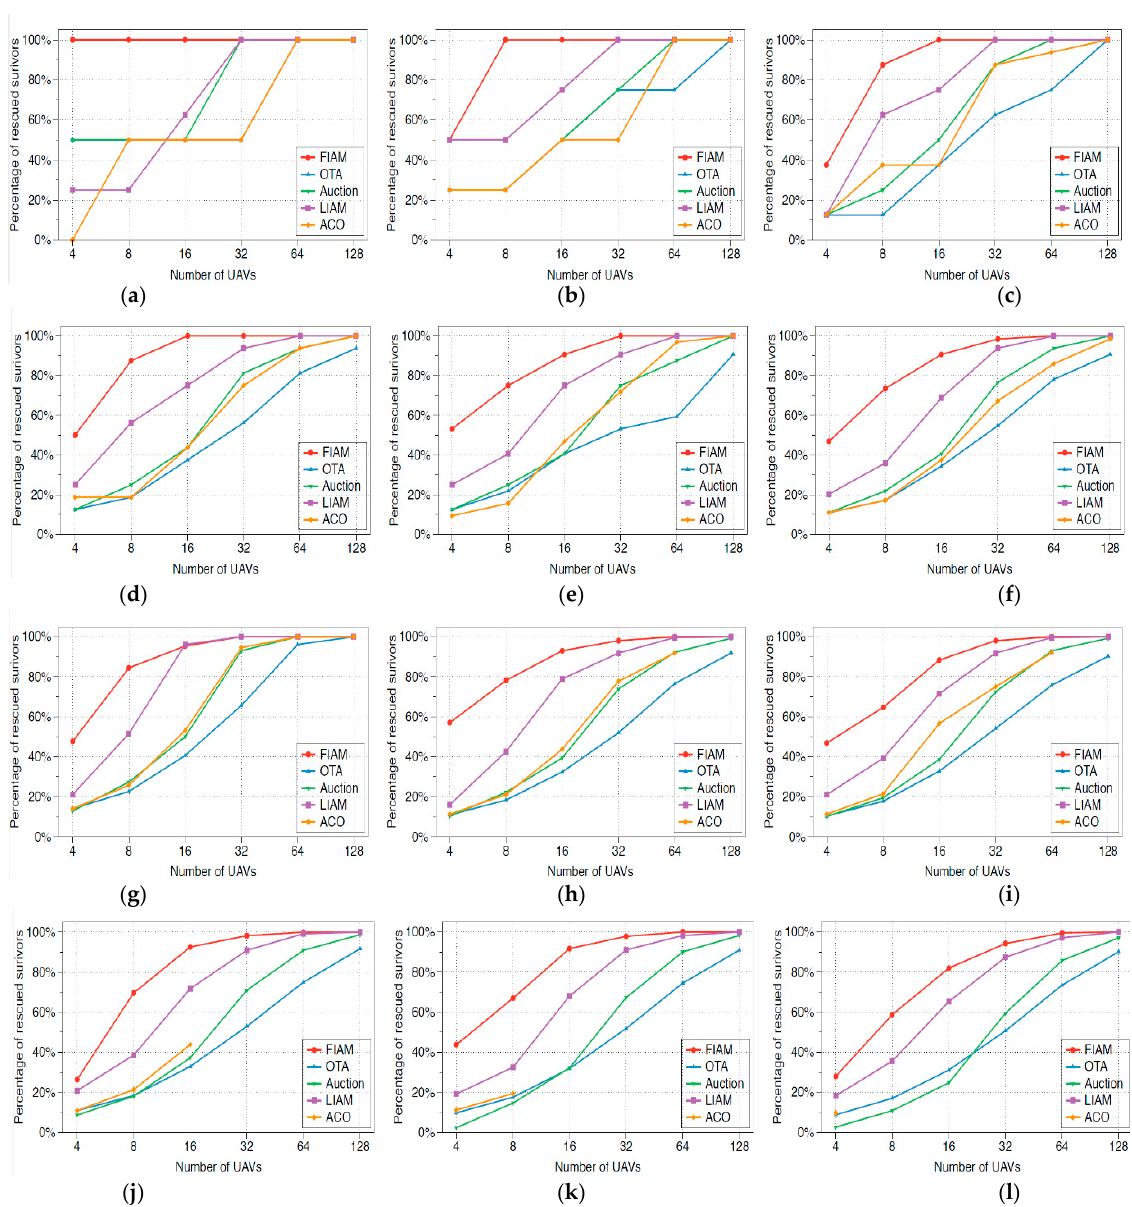
Figure 5. Net throughput as the number of survivors increased from 2 to 4096. ( a ) Net throughput for 2 survivors. ( b ) Net throughput for 4 survivors. ( c ) Net throughput for 8 survivors. ( d ) Net throughput for 16 survivors. ( e ) Net throughput for 32 survivors. ( f ) Net throughput for 64 survivors. ( g ) Net throughput for 128 survivors. ( h ) Net throughput for 256 survivors. ( i ) Net throughput for 512 survivors. ( j ) Net throughput for 1024 survivors. ( k ) Net throughput for 2048 survivors. ( l ) Net throughput for 4096 survivors. UAV, Unmanned Ariel Vehicle; FIAM, fish-inspired algorithm for task allocation in multi-UAV missions; OTA, opportunistic task allocation; ACO, ant colony optimization; LIAM, locust-inspired algorithm for MUTA problem.